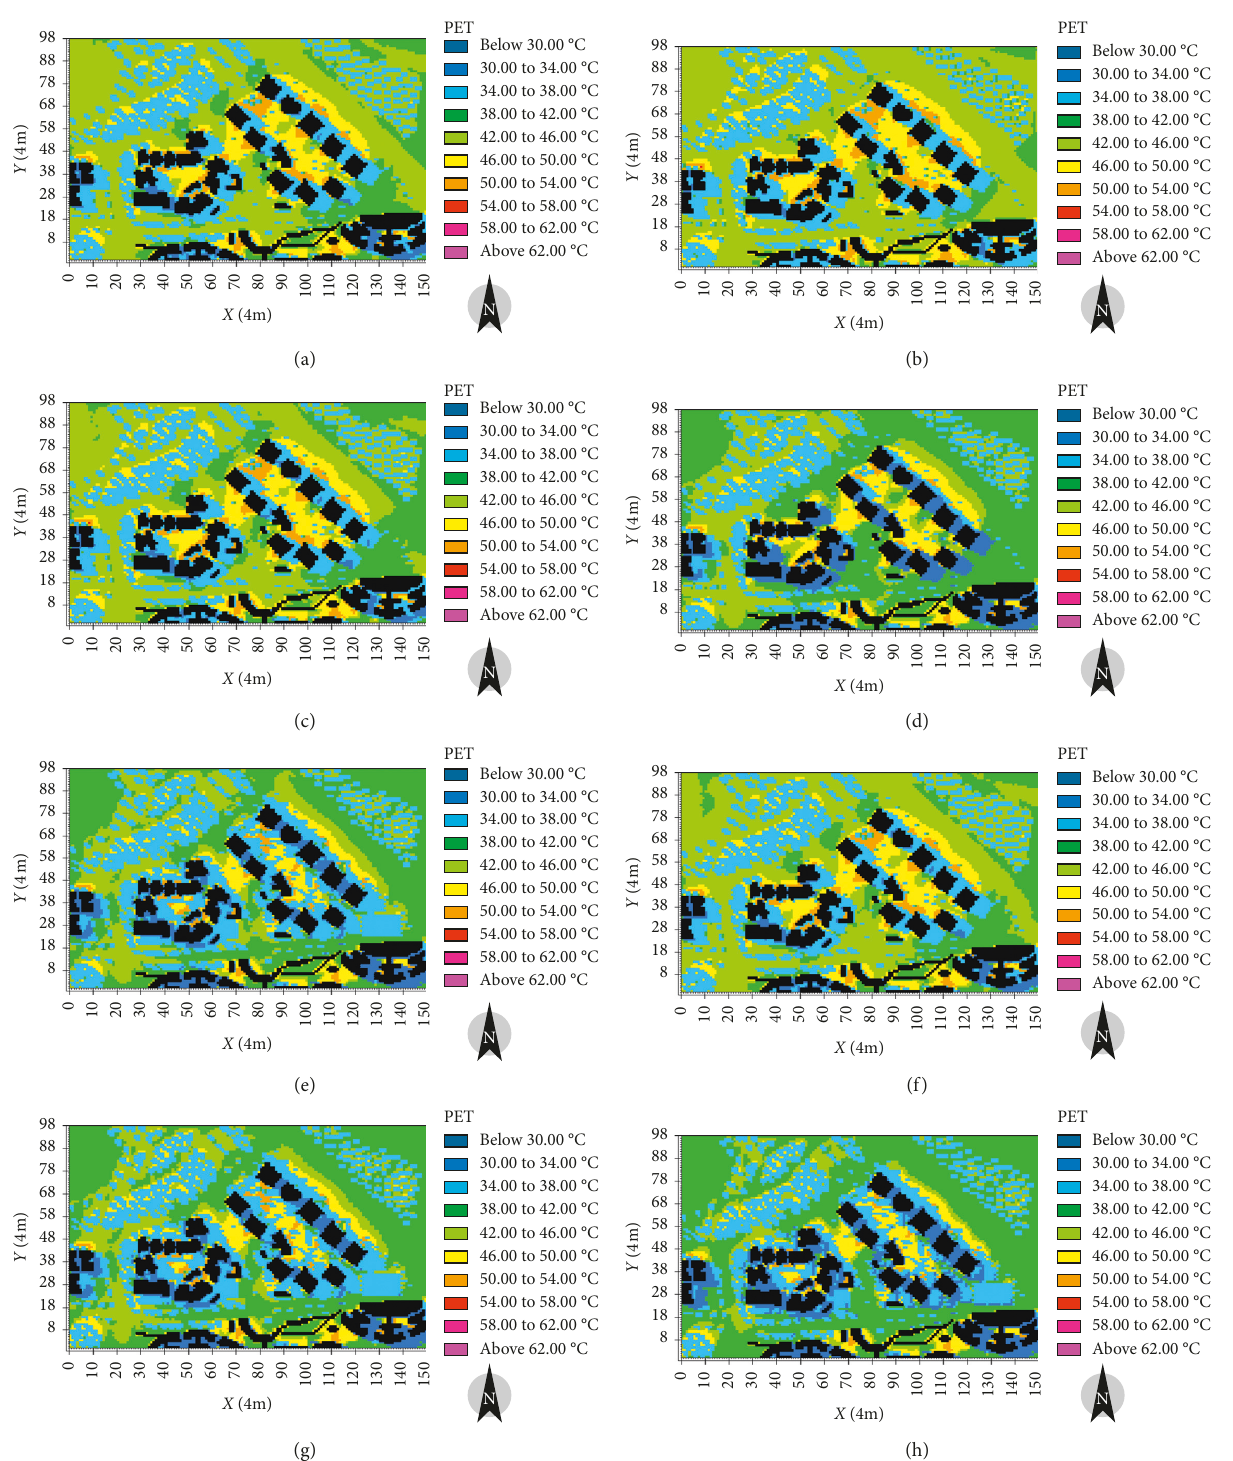
Figure 9: Simulated PETfor all the design scenarios. (a) Base case. (b) Scenario 1 (wooden boards). (c) Scenario 2 (light-color granite). (d) Scenario 3 (grass surface). (e) Scenario 4 (more trees). (f) Scenario 5 (more water bodies). (g) Scenario 6 (light-color granite +more trees). (h) Scenario 7 (grass surface +more